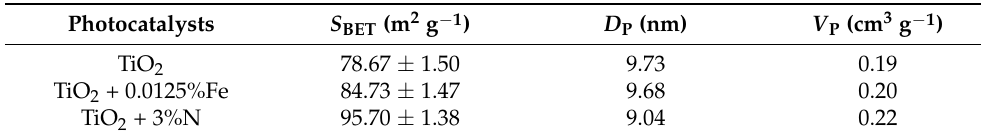
Figure 5. Nitrogen adsorption-desorption isotherms of ( A ) TiO 2 , ( B ) 0.0125% Fe, and ( C ) 3%N. Table 1. BET surface areas ( S BET ), pore volume ( V p ), and pore diameters ( D p ) for the N-, Fe-, and N-Fe doped TiO 2 photocatalysts.